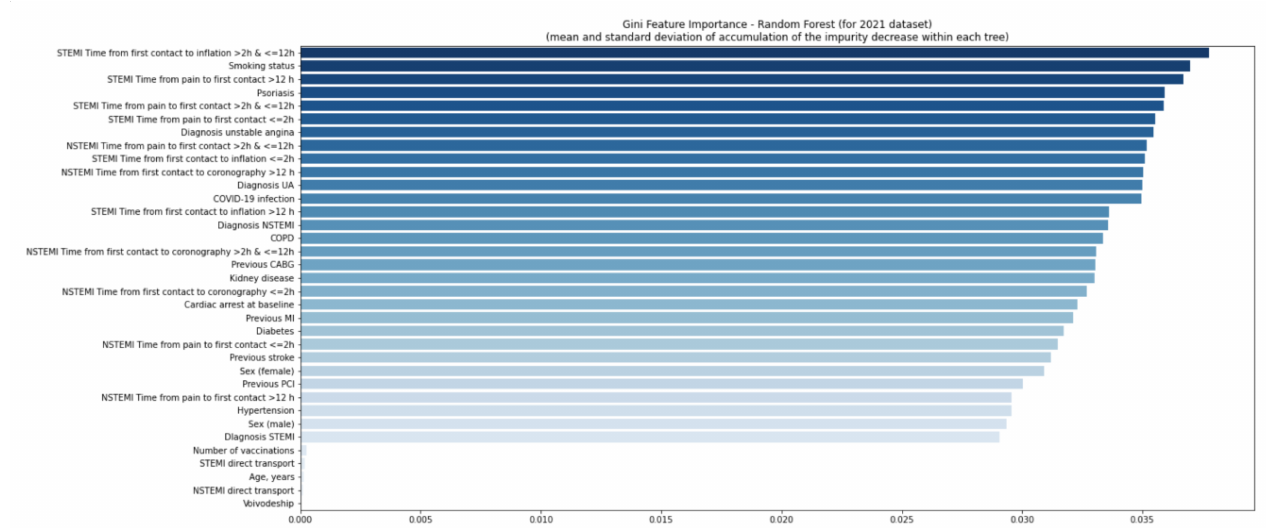
Figure 7. Gini feature importance analysis for patients in 2021. Diagram shows the mean decrease of the model’s impurity. In the analysis, each feature’s importance is calculated as the sum over the number of splits across all trees, which includes the feature proportional to the number of samples in the split. In the random forest model, the variable is considered important if the tree split on this variable is affected by large impurity (labels homogeneity in the node) and decreases. CABG—coronary artery bypass graft; COPD—chronic obstructive pulmonary disease; MI—myocardial infarction; NSTEMI—non-ST-elevation myocardial infarction; PCI—percutaneous coronary intervention; Q—quartile; STEMI—ST-elevation myocardial infarction; UA—unstable